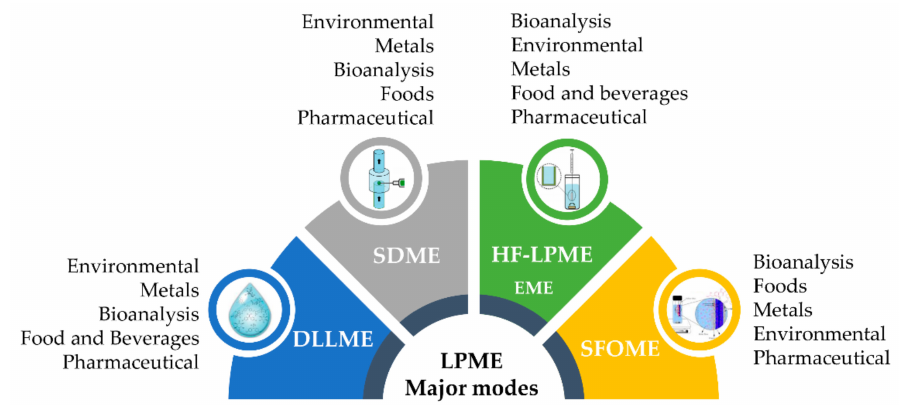
Figure 1. The most popular modes of LPME techniques and a thematic distribution of their main applications (decreasing order as reported in the literature). LPME: liquid phase membrane extraction; DLLME: dispersive liquid-liquid phase microextraction-, SDME: -single drop micriextraction, HF- LPME: hallow fibre liquid phase microextraction; -SFOME: solidification of floating organic